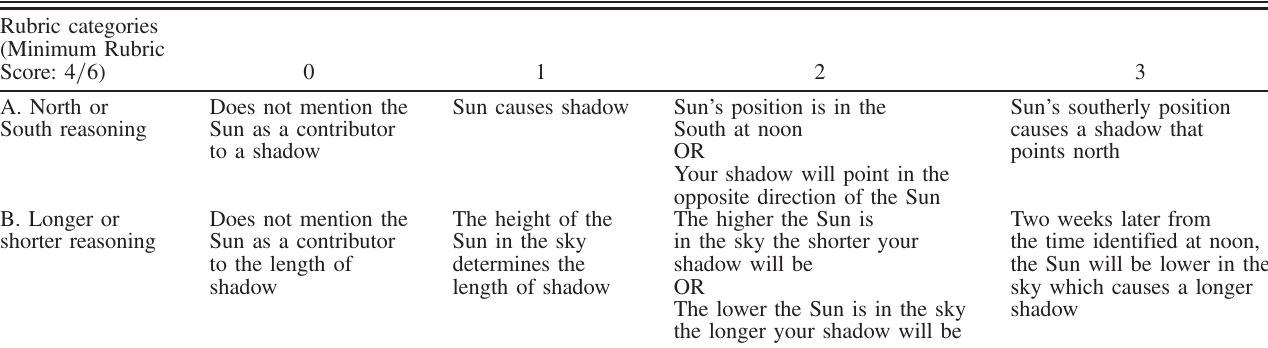
FIG. 10. Assessment used to measure students ’ ability to identify how the direction and length of their shadow change over a given time period. The distributions of students choosing the correct multiple-choice response and attaining the minimum rubric score can be found in Fig. 3. This question was adapted from the Center for Astronomy Education exam